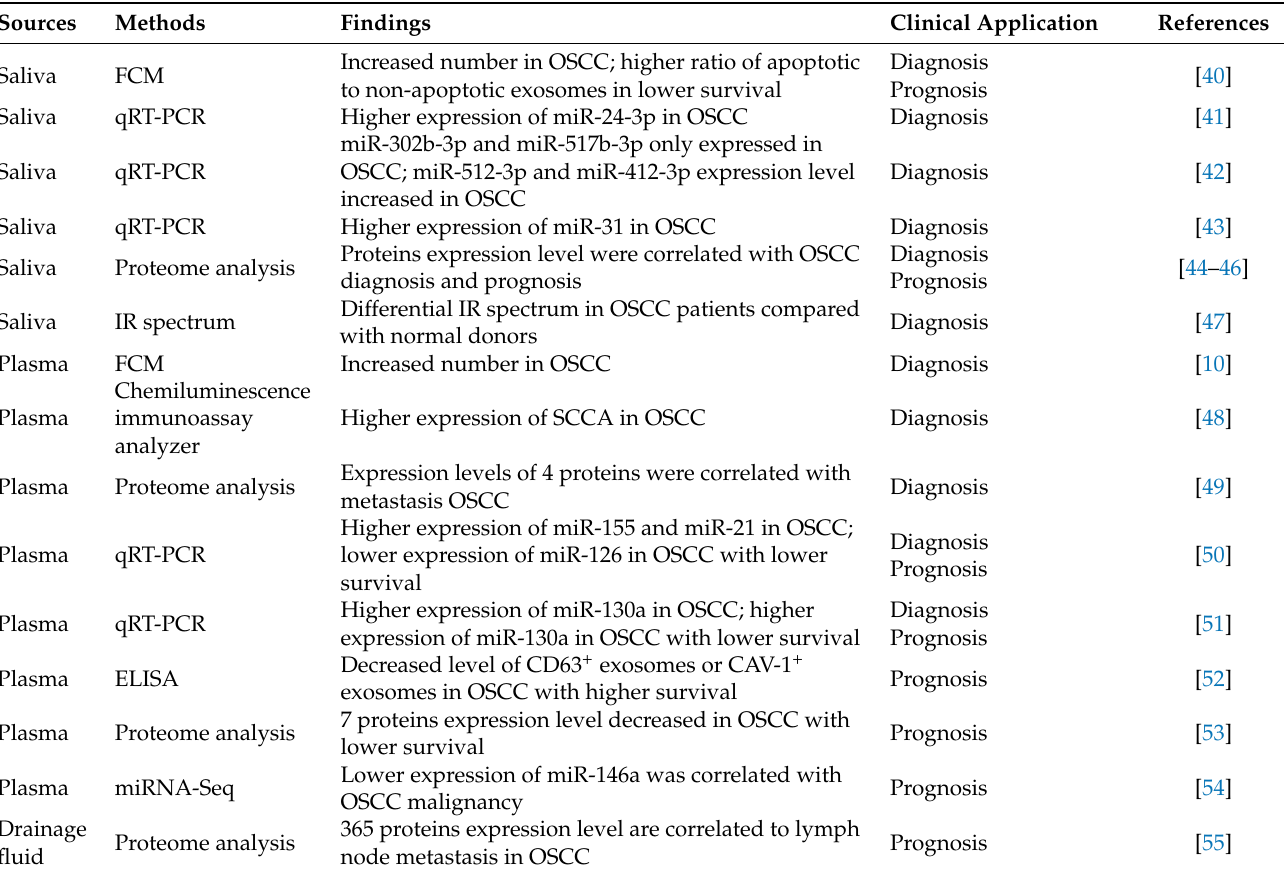
Table 2. Potential applications of exosomes from different samples collected from OSCC patients and healthy donors using different detecting